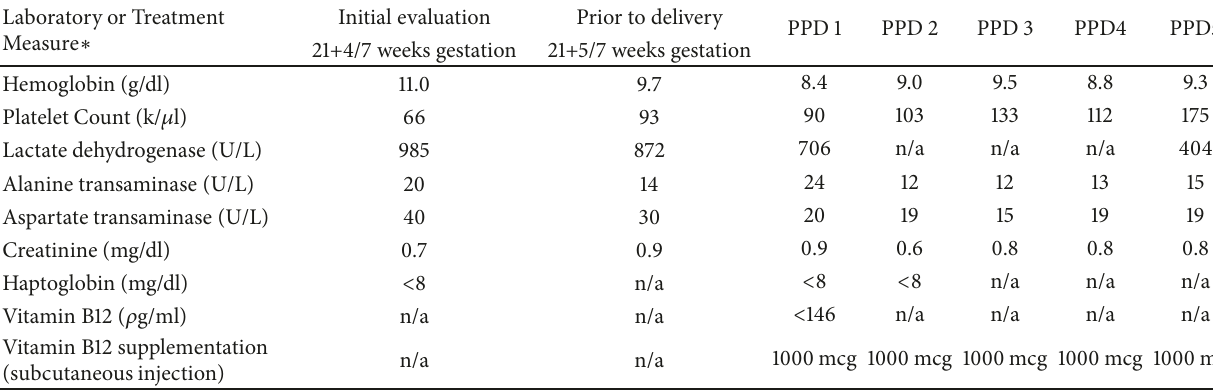
Table 1: Laboratory or treatment measures before and after